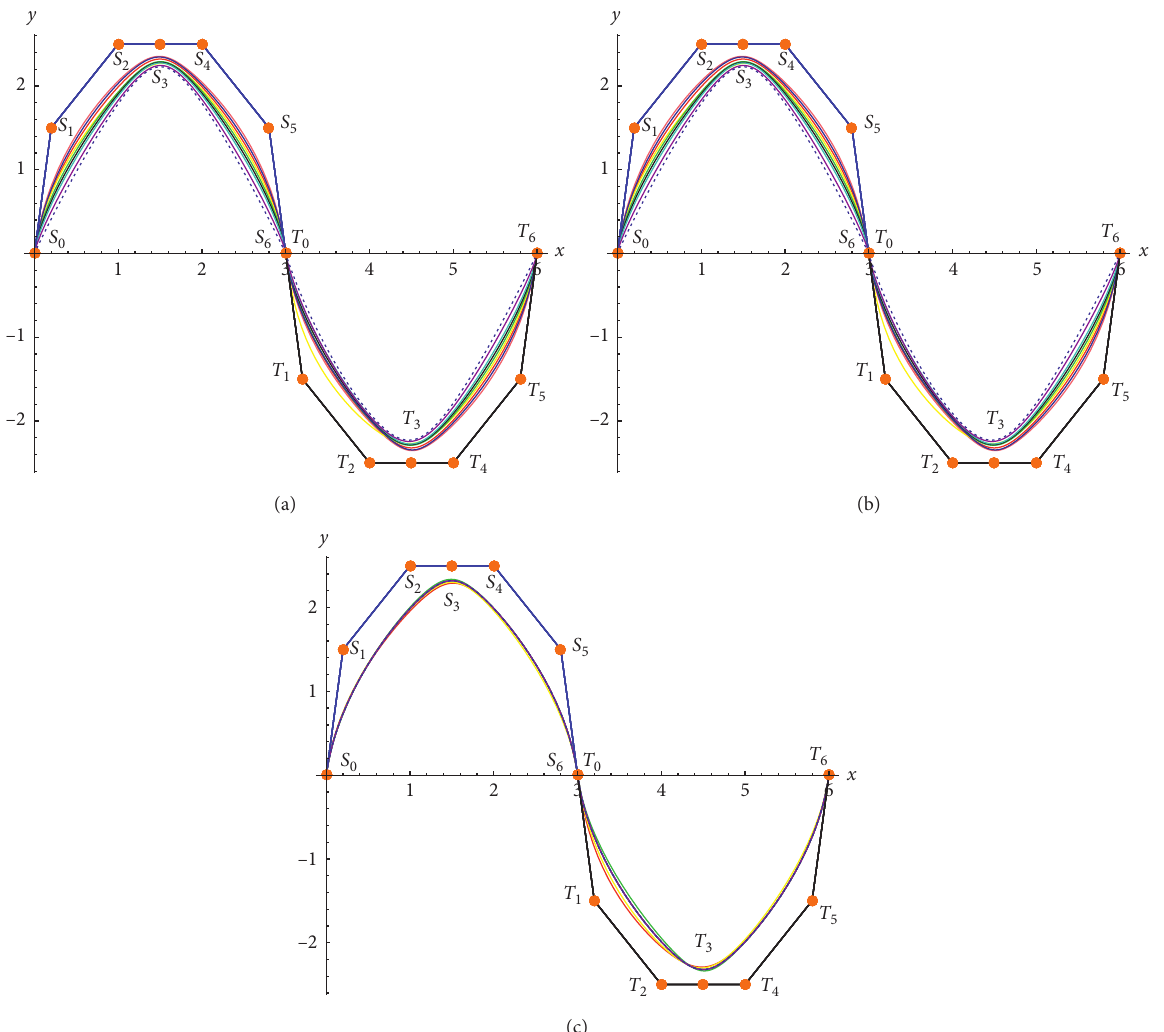
Figure 6: C 0 continuity of ST-B´ezier curve segments with various shape